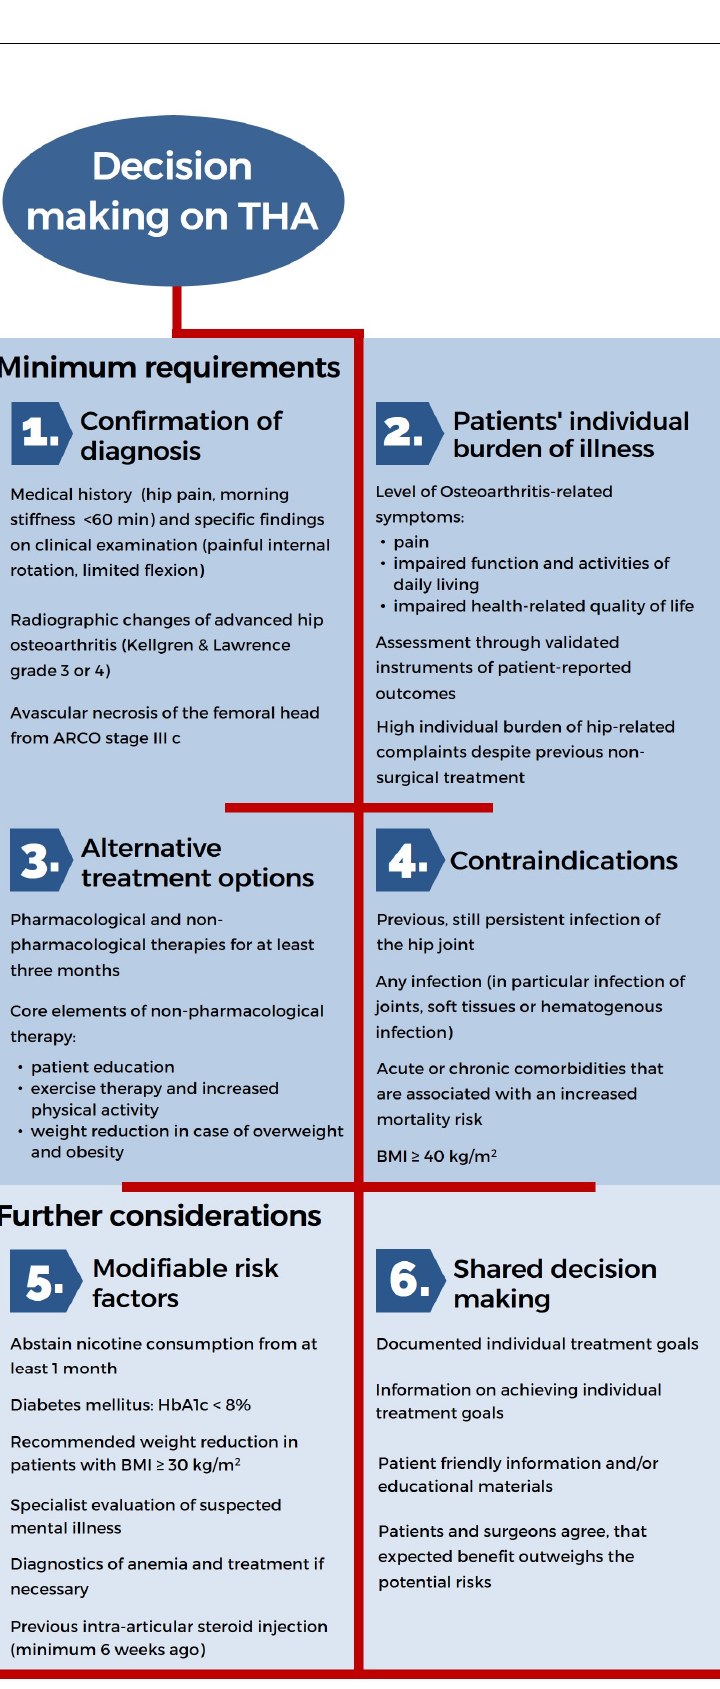
Figure 2. EKIT-Algorithm for decision making on THA.